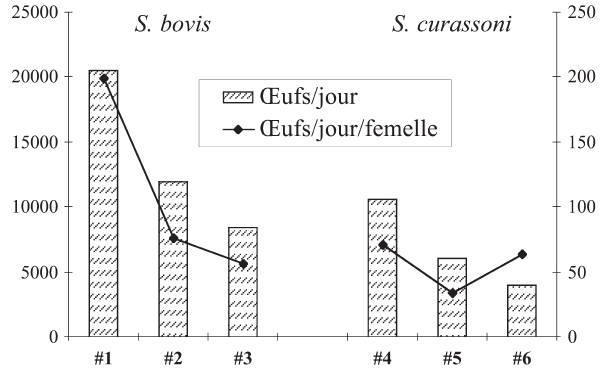
Fig. 3. – Excrétions fécales quotidiennes moyennes d’œufs chez des caprins expérimentalement infestés par deux espèces de schistoso- mes. Trois animaux par